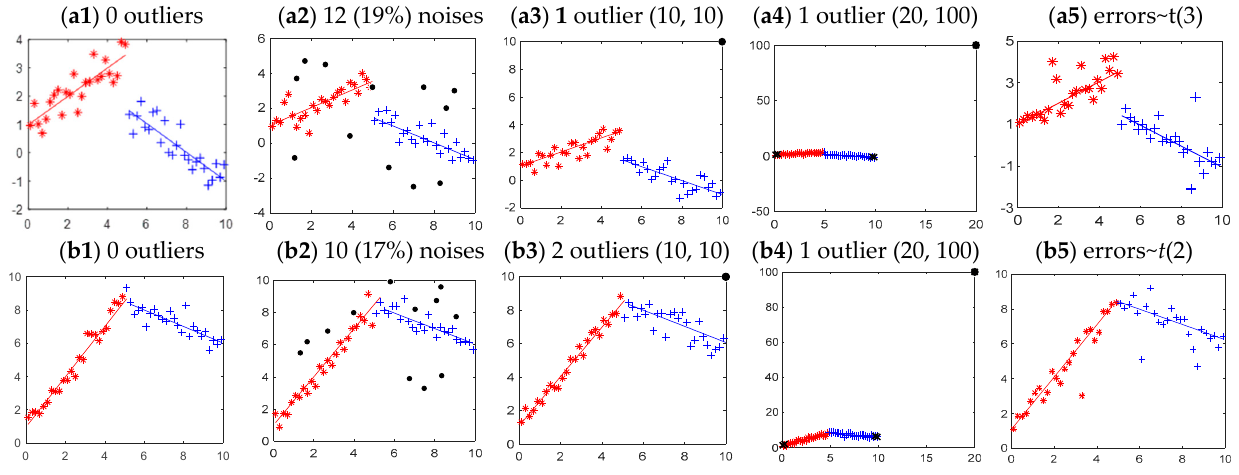
Figure 2. Plots of Models (a) and (b), true parameters and one simulated series from each respective contamination scenario. Model expression